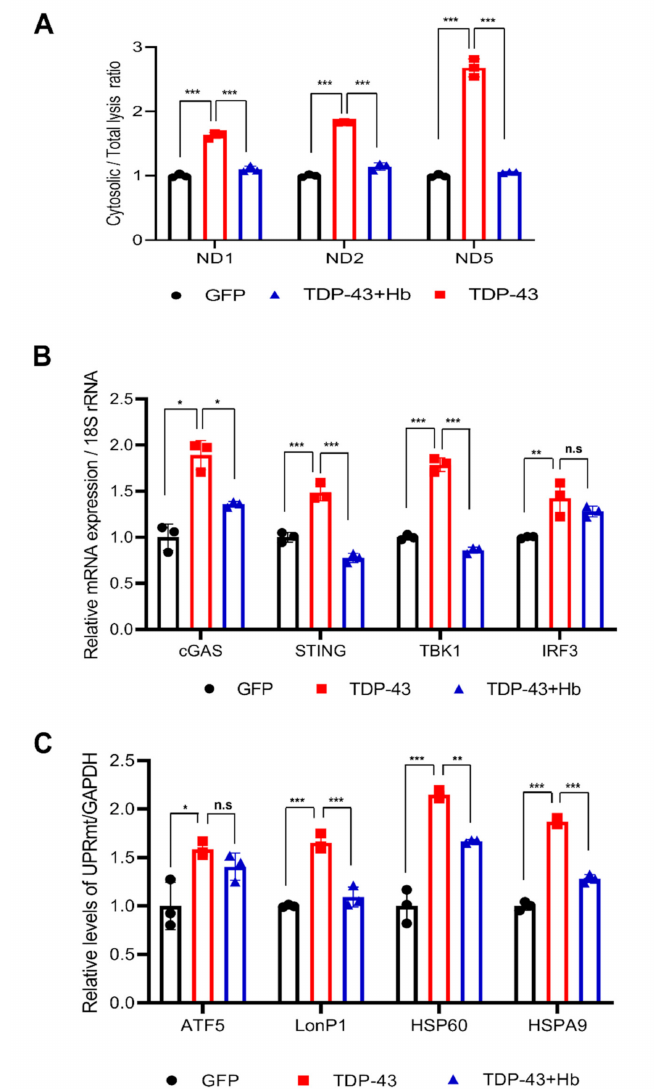
Figure 6. Hydroxocobalamin reduces TDP-43-induced mitochondrial DNA release and mitochondrial UPR activation. Cells expressing GFP- or GFP-tagged human WT TDP-43 were treated with Hb (10 µ M) for 24 h during infection for 2 days ( A , B ) or 3 days ( C ). ( A ) DNA was extracted from the cytoplasmic fraction or whole cell lysate. The ratio of cytoplasmic to total mtDNA was determined using real-time PCR. Mitochondrial genes ( ND1 , ND2 , and ND5 ) were normalized to the comparative CT value of the nuclear gene POLG . Values are presented as the means of individual measurements in each sample ± SD. *** p < 0.001 (one-way ANOVA multiple comparisons with Tukey’s post-hoc test). Using flow cytometry, only GFP-positive cells were collected and used for the mRNA analysis ( B , C ). ( B ) cGAS-STING pathway-related gene expression ( cGAS , STING , TBK1 , and IRF3 ) following TDP-43 overexpression in SH-SY5Y cells was measured using real-time PCR, and the expression of these genes was significantly increased by TDP-43 and reduced by Hb treatment. 18S rRNA was used for normalization. Data are presented as the means ± SD of three independent experiments. * p < 0.05, ** p < 0.01, *** p < 0.001, and n.s., not significant (one-way ANOVA with Tukey’s multiple comparison test). ( C ) Expression levels of mtUPR-related genes, including ATF5 , LonP1 , HSP60 , and HSPA9 , were detected using RT–PCR. GAPDH was used as an internal control. Error bars represent the mean values ± SD of three independent experiments. The significance of differences was determined using one-way ANOVA with Tukey’s multiple comparison test (** p < 0.01, *** p < 0.001, and n.s., not